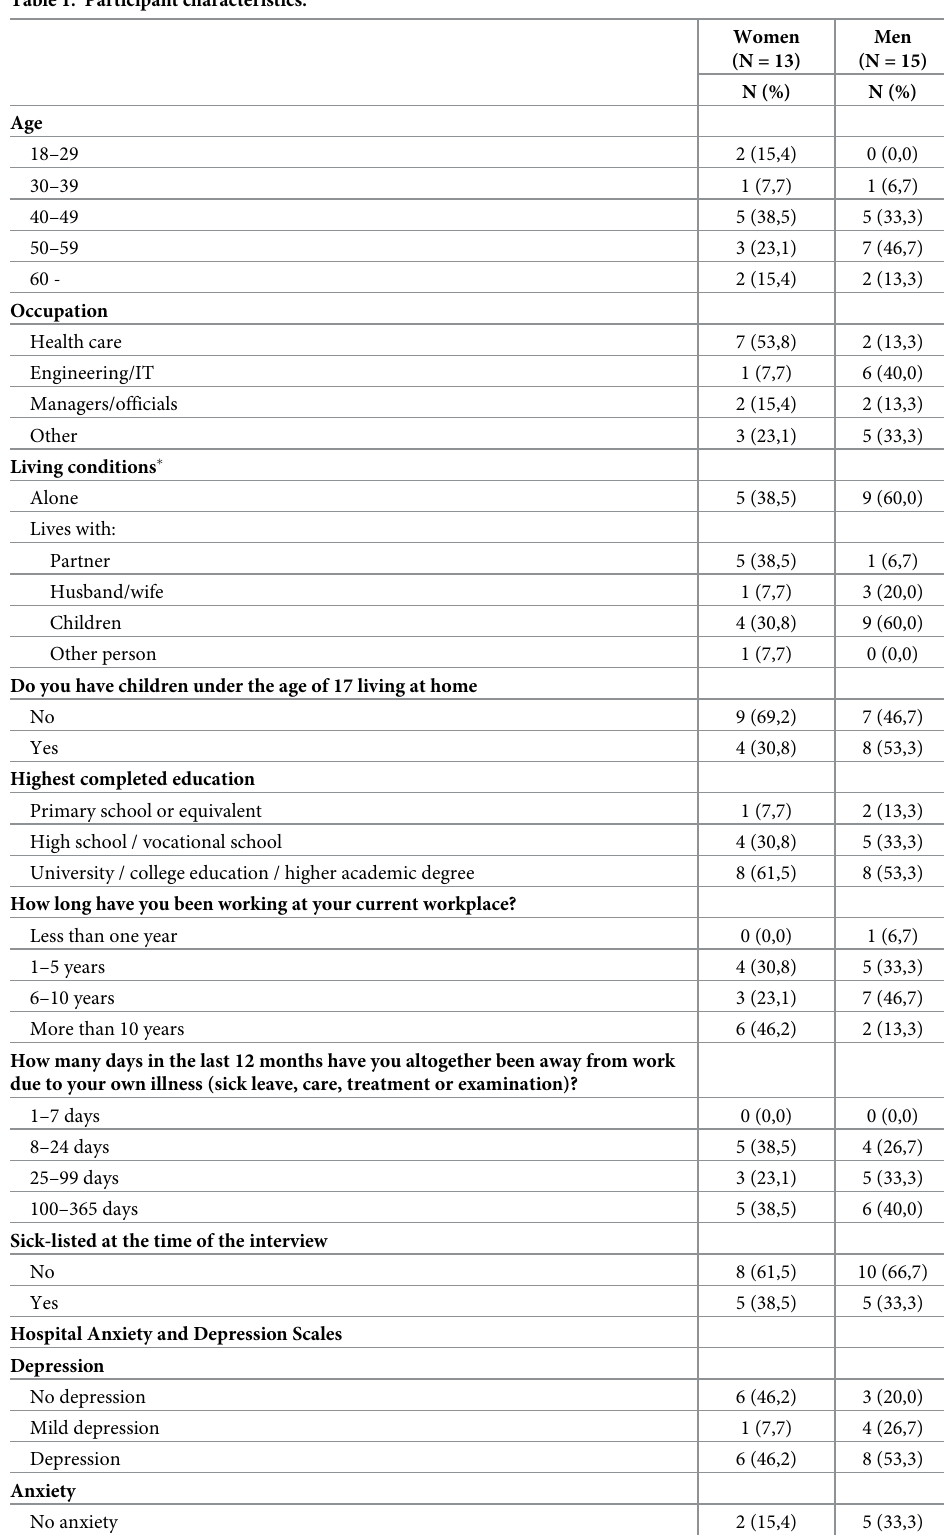
Table 1. Participant